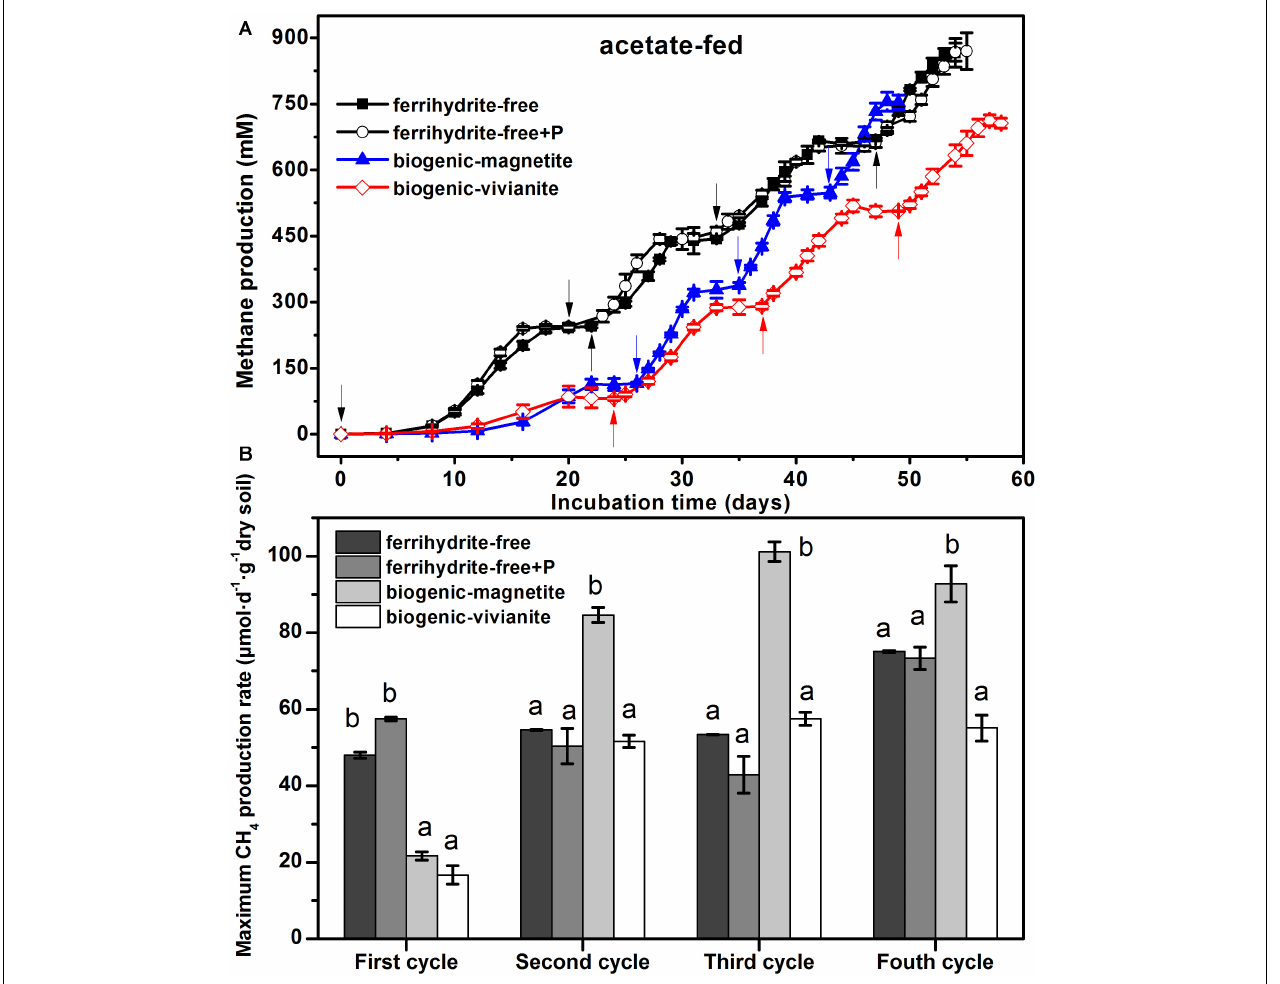
FIGURE 1 | CH 4 yield (A) and CH 4 production rate (B) in the acetate-fed cultures (different letters indicate significant differences among four treatments in a feeding cycle; the arrows denote the addition of acetate).